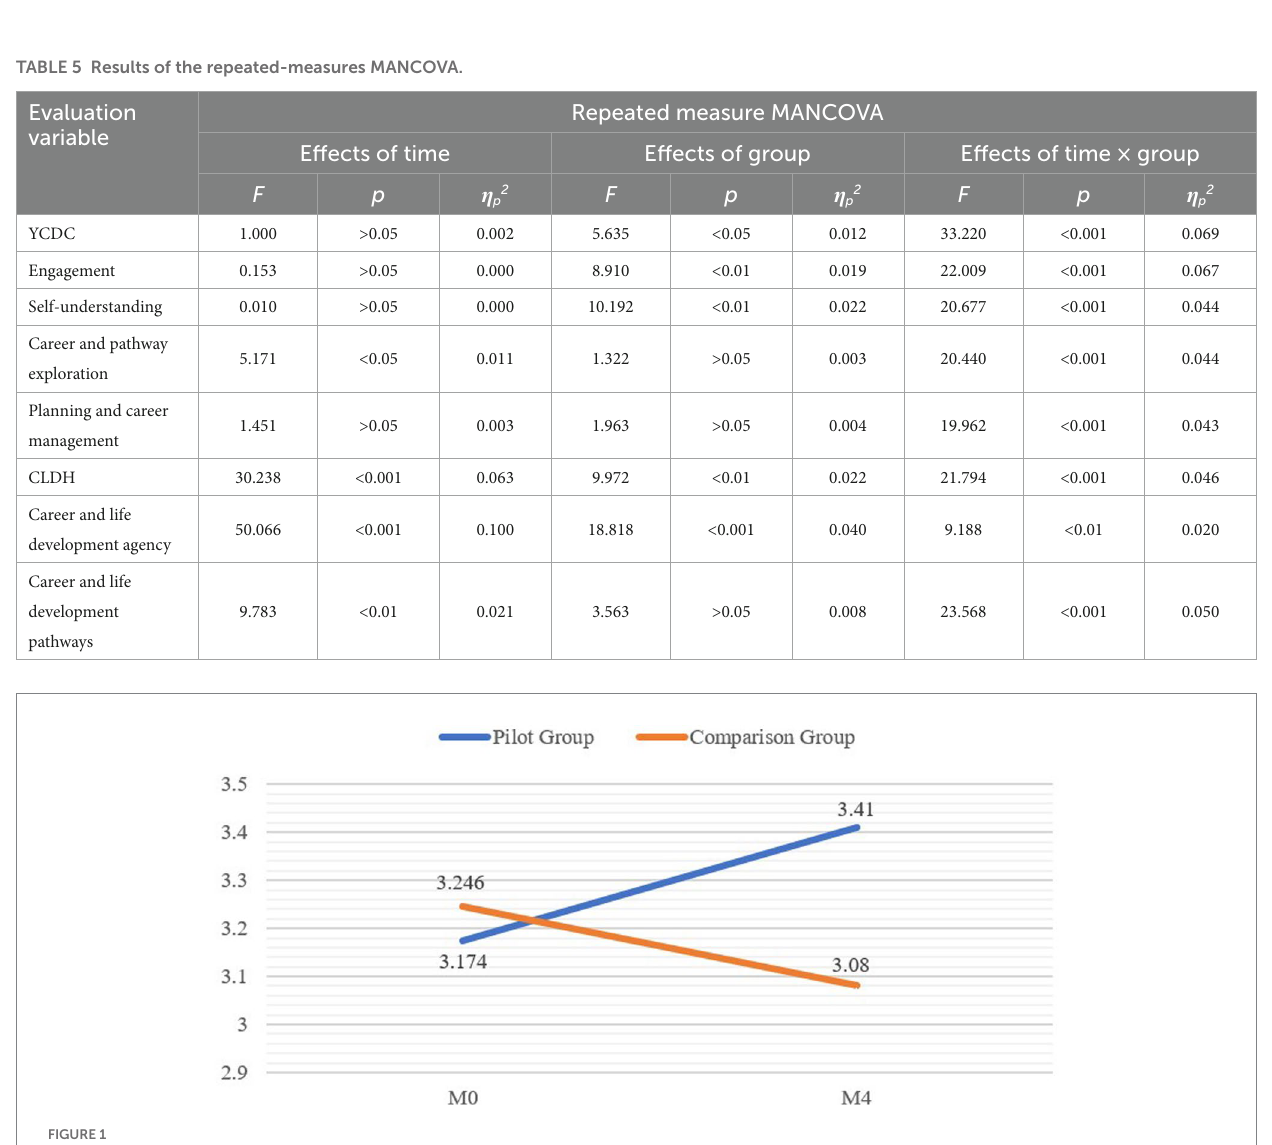
FIGURE 1 Group comparison of youth career development competency from